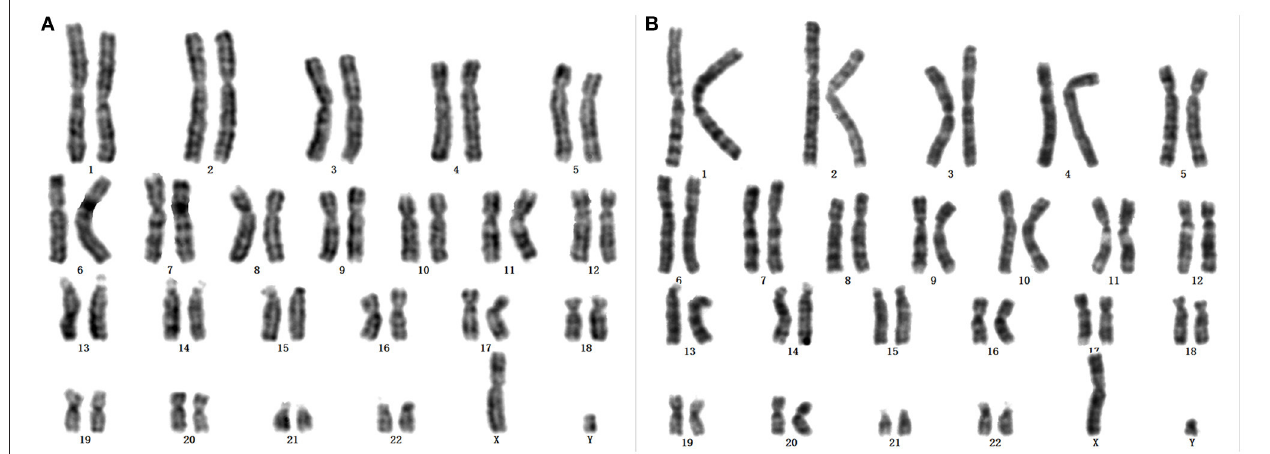
FIGURE 1 | (A) Karyotype of the proband: 46, X, + mar. (B) Karyotype of father to the proband: 46, X, Yq-.